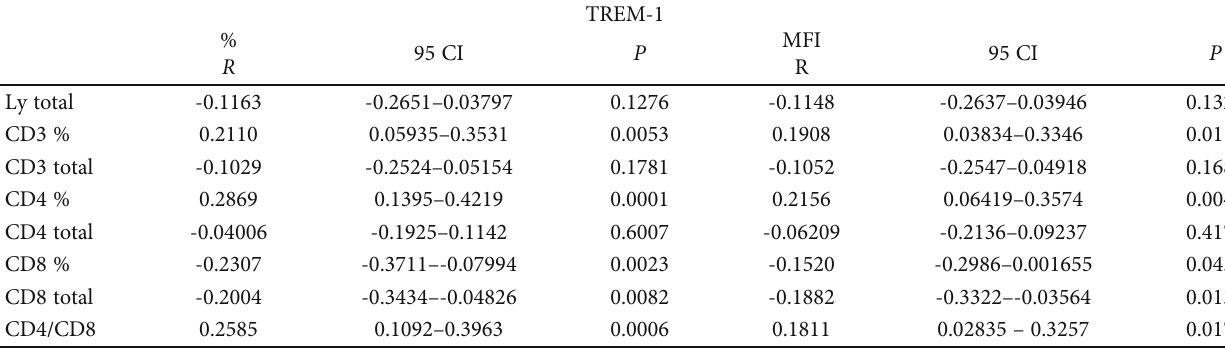
Table 4: TREM-1 and T cells correlation